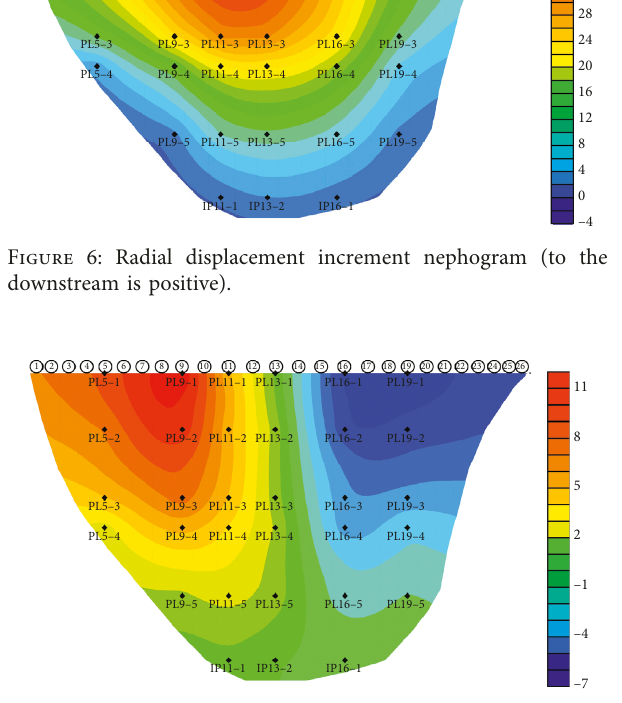
Figure 7: Tangential displacement increment nephogram (to the left bank is